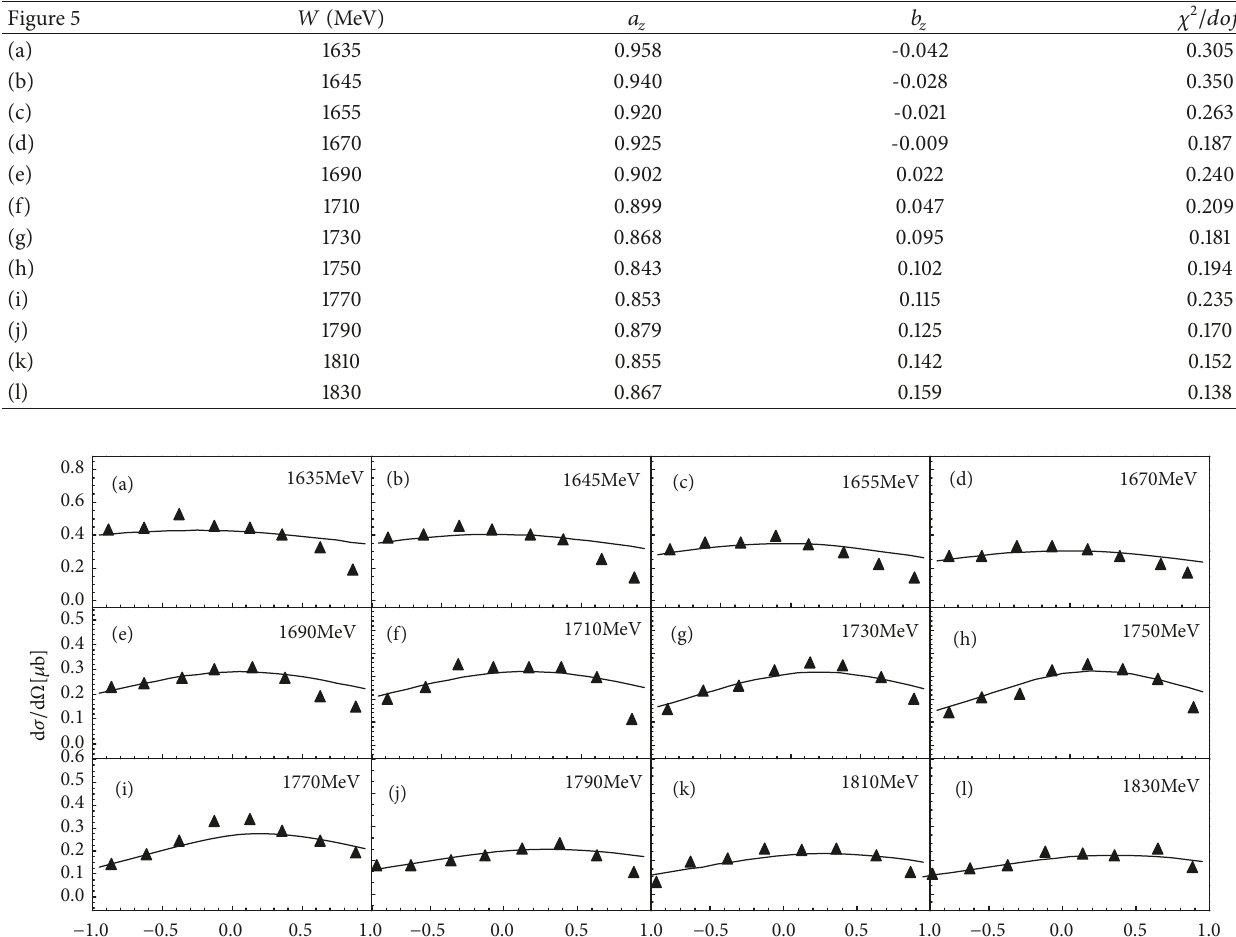
Table 5: Values of 𝑎 𝑧 and 𝑏 𝑧 taken in Figure 5 model results.